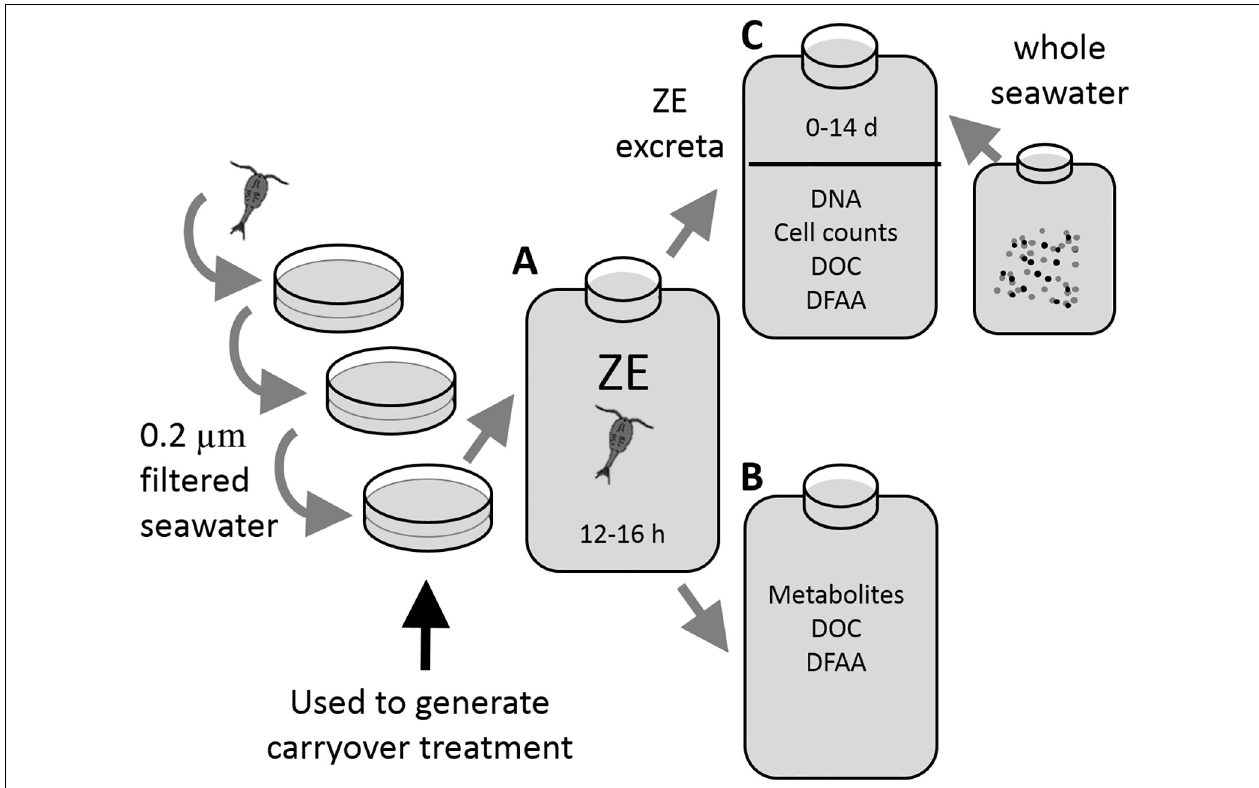
FIGURE 1 | Experimental protocol for the zooplankton excreta production experiments (A) , the water of which was used to either measure metabolites (B) , or perform the microbial remineralization experiments (C) . Copepods were serially rinsed and then incubated in filtered seawater for 12–16 h to generate excreta for analysis. For the microbial remineralization experiment 1,150 mL zooplankton excreta water was re-filtered through a 0.2 µ m Omnipore filter and inoculated with 500 mL of whole seawater communities from 200 m and allowed to incubate for up to 14 days. At regular intervals the samples were collected for bacterioplankton cell abundance, 16S rRNA gene amplicon sequencing, DOC concentration, and dissolved free amino acids (DFAA)